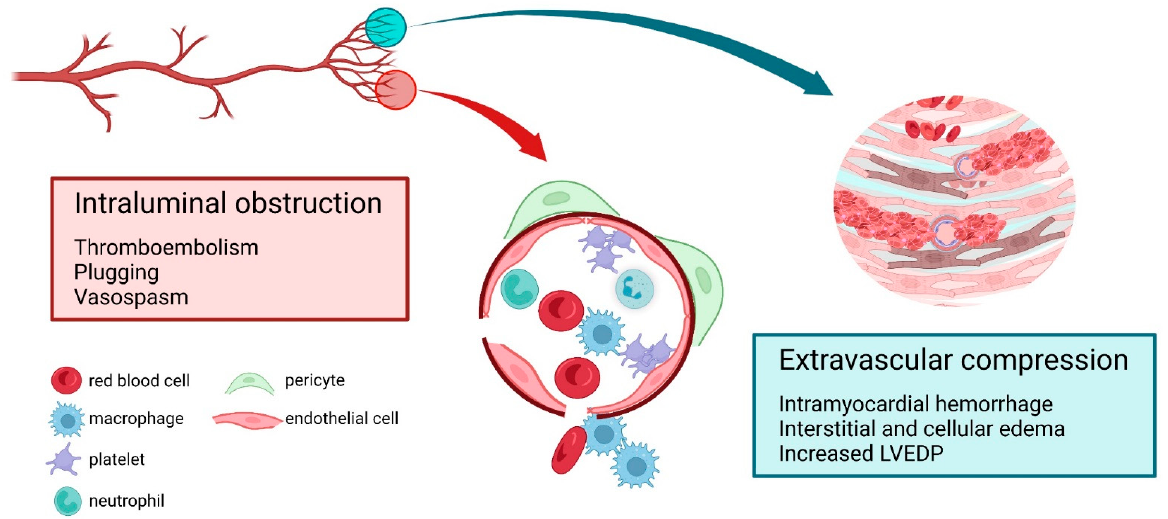
Figure 1. Pathophysiological mechanisms contributing to coronary microvascular dysfunction in patients with acute myocardial infarction. Created with BioRender.